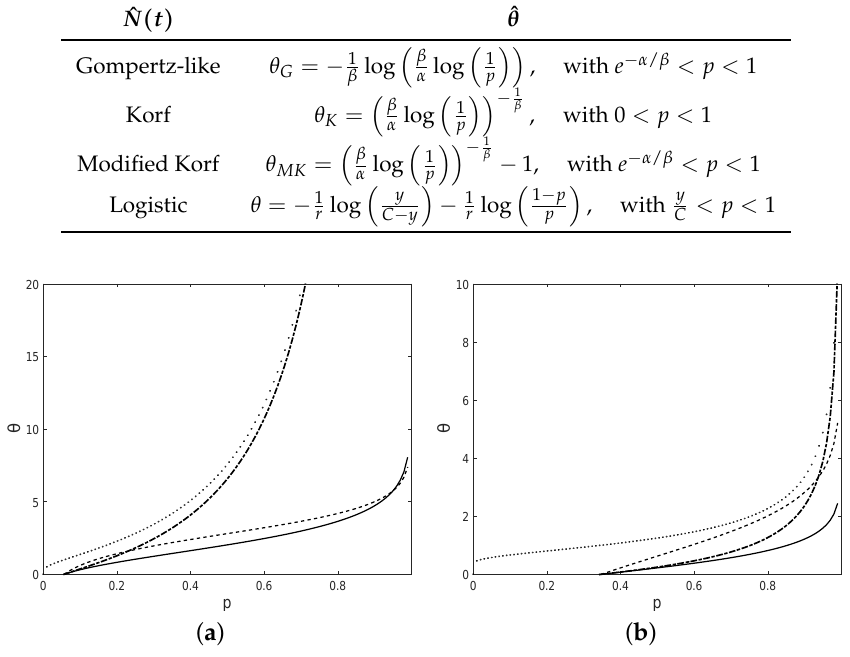
Figure 6. The threshold crossing times θ G (solid), θ K (dotted), θ MK (dot-dashed), and θ (dashed) with α = 2, y = 0.1, A = 0.1, r = 1, ( a ) β = 0.7 and C = 1.7412, ( b ) β = 1.9 and C =